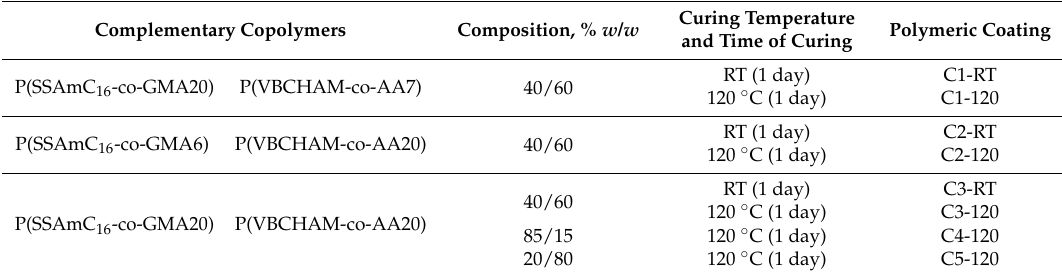
Table 2. Composition and curing conditions of the P(VBCHAM-co-AAx) and P(SSAmC 16 -co-GMAx) complementary antimicrobial copolymers coated onto glass